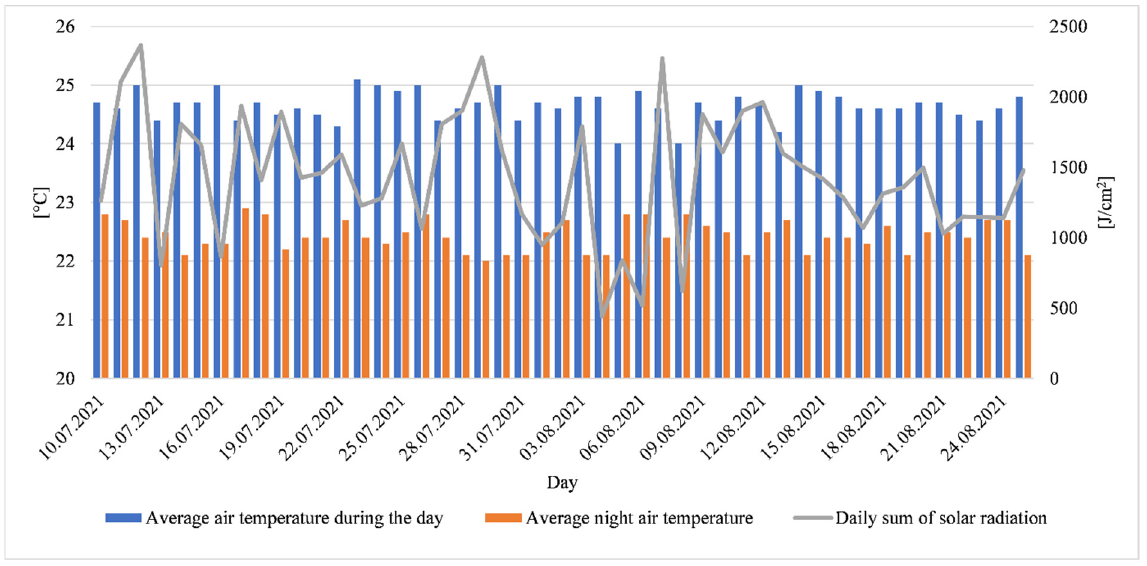
Figure 2. Climate parameters in the cultivation chamber during the experiment—season